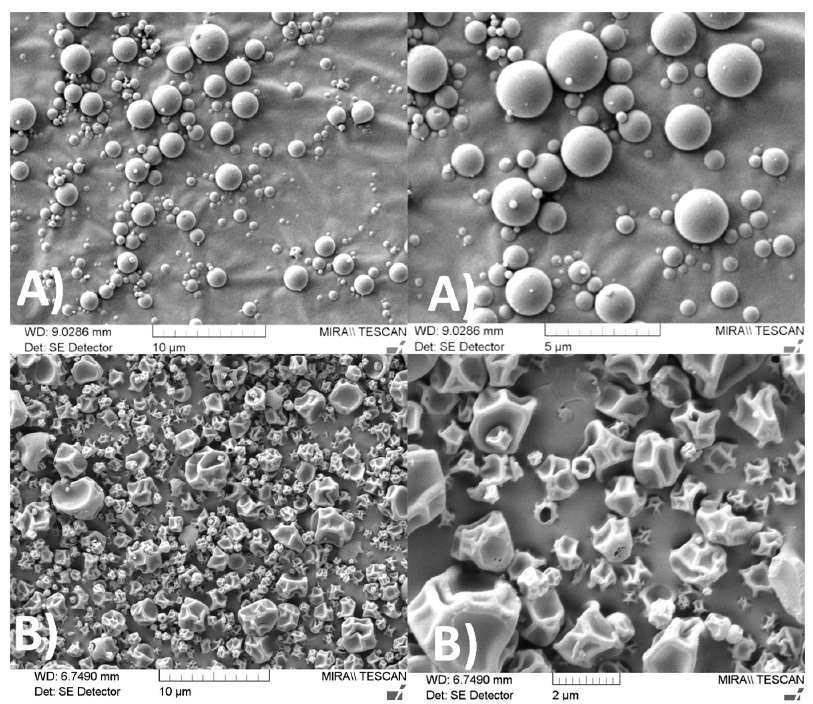
Figure 2. SEM micrographs of ( A ) spray-dried INU, ( B ) INU-COLI. The samples were coated with a 10 nm-thick gold film. Primary electrons were accelerated under a voltage of 5 kV. Images were formed from the collection of secondary electrons.